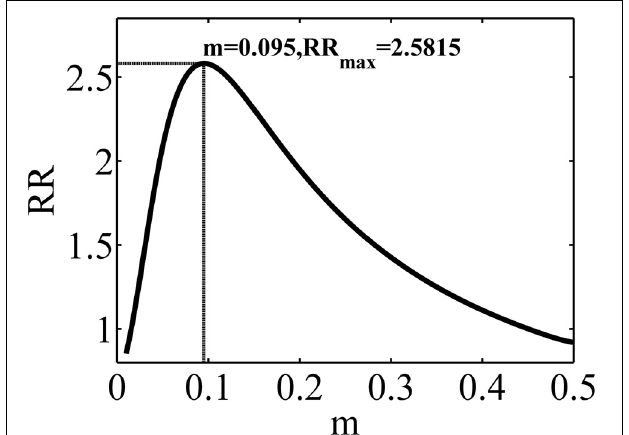
FIGURE 8 | The average reward rate in the experiment considered in simulation 1, as a function of m , the mean of the Gaussian policy. This function is computed using the method described in Supplementary